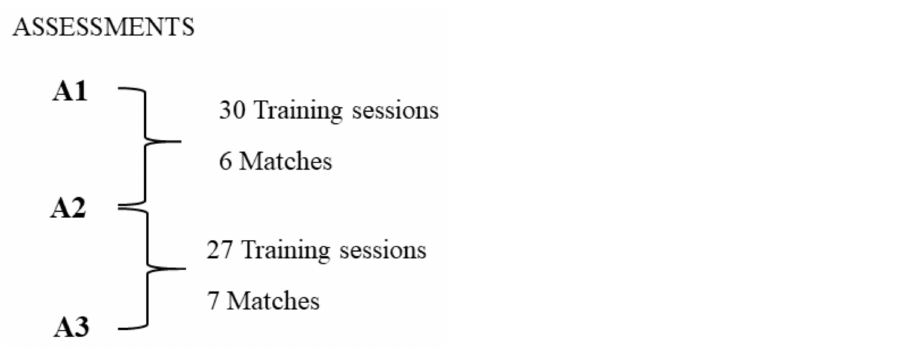
Figure 1. Timeline of the study. Legend: A1. Assessment 1; A2. Assessment 2; A3. Assessment 3. Table 1. Training and match RPE and duration between the three assessments. Periods Between A1 and